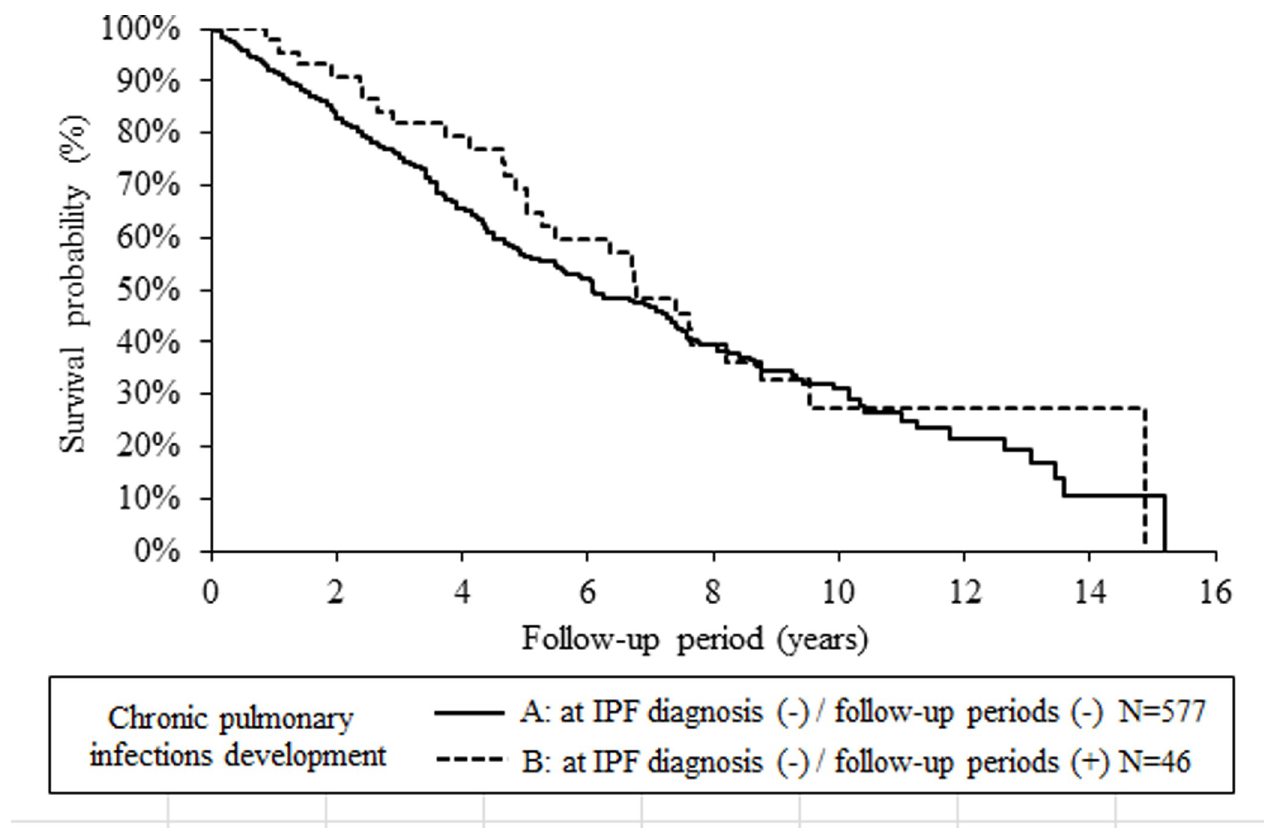
Fig 3. Kaplan-Meier survival curves according to the presence or absence of CPI (Group A versus B). A log-rank test showed that the difference was not significant (p = 0.416).